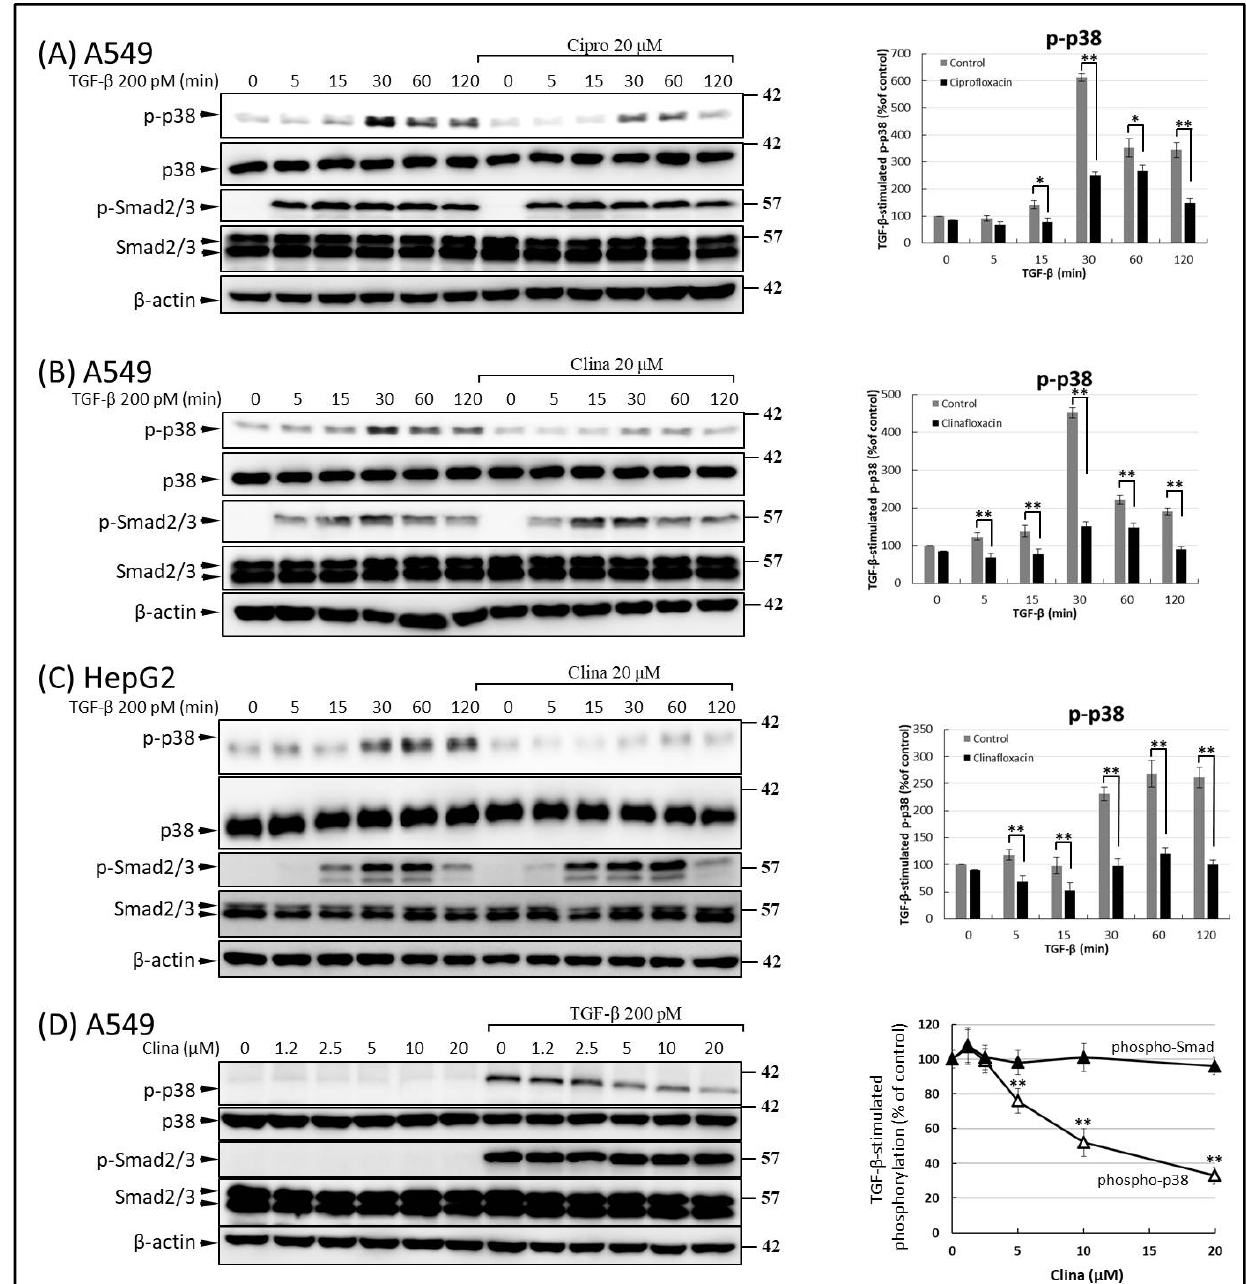
Figure 5. Transforming growth factor beta (TGF- β )-stimulated activation of p38, but not of Smad, was inhibited by fluoroquinolones (FQs). Cultured A549 and HepG2 cells were serum-deprived for 24 h before growth factor stimulation. A549 ( A – D ) and HepG2 ( C ) cells were incubated in the presence of 20 µ M ciprofloxacin ( A ) or clinafloxacin ( B , C ) for 30 min before incubation with 200 pM TGF- β for the indicated times. Smad2/3 and p38 phosphorylations were determined by Western blotting. Phosphorylated protein levels of the indicated experimental groups were quantified as a percentage relative to the level of the control experiments. Data are representative of at least three independent experiments (right-hand panel; * p ≤ 0.05, ** p ≤ 0.01). ( D ) Because the maximal stimulation of p38 activation by TGF- β is approximately 30 min, A549 cells were treated with 200 pM TGF- β in the absence or presence of the indicated concentrations of clinafloxacin for 30 min, and Smad2/3 and p38 phosphorylation were determined by Western blotting as described in ( A ). Phosphorylated protein levels of the indicated experimental groups were quantified as a percentage relative to the level of TGF- β -treated cells (right-hand graphs; ** p ≤ 0.01).